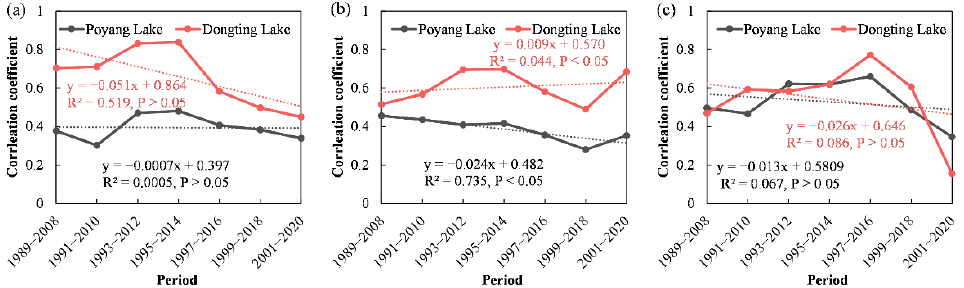
Figure 14. Multiscale correlation between mean water occurrence and precipitation, inflow runoff, and upstream runoff in Poyang Lake and Dongting Lake. ( a – c ) indicate precipitation, inflow runoff, and upstream runoff,